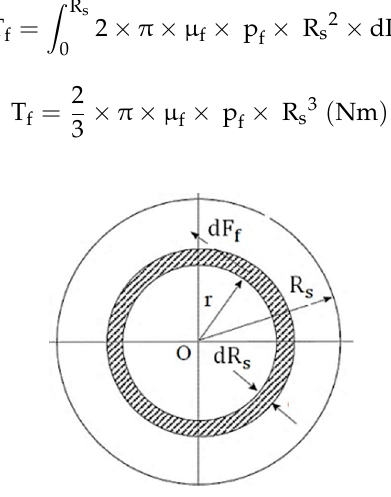
Figure 3. Representation of the friction force acting at the elemental radius.